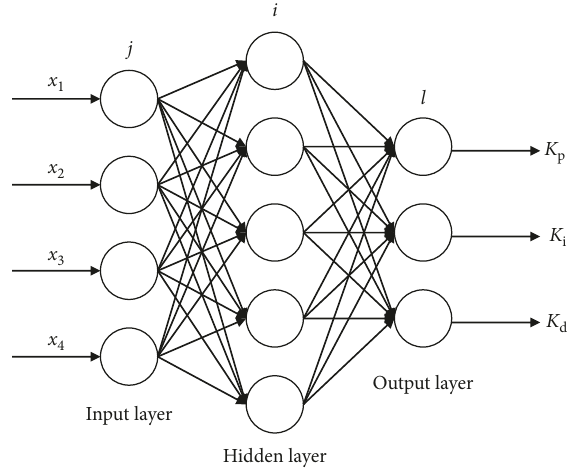
Figure 1: BP neural network